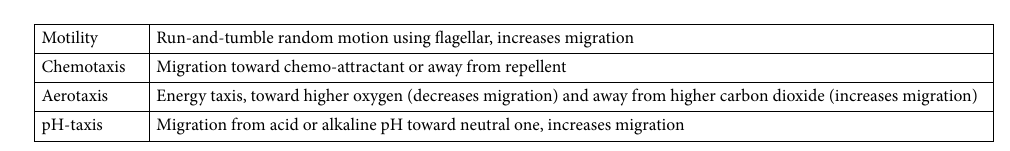
Table 1. List of the factors that influence transports included in this